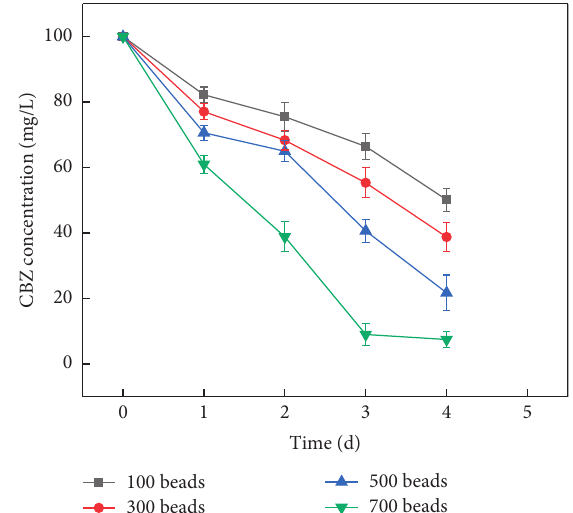
Figure 5: Effect of the dosage of the ANFICV bead on the removal of